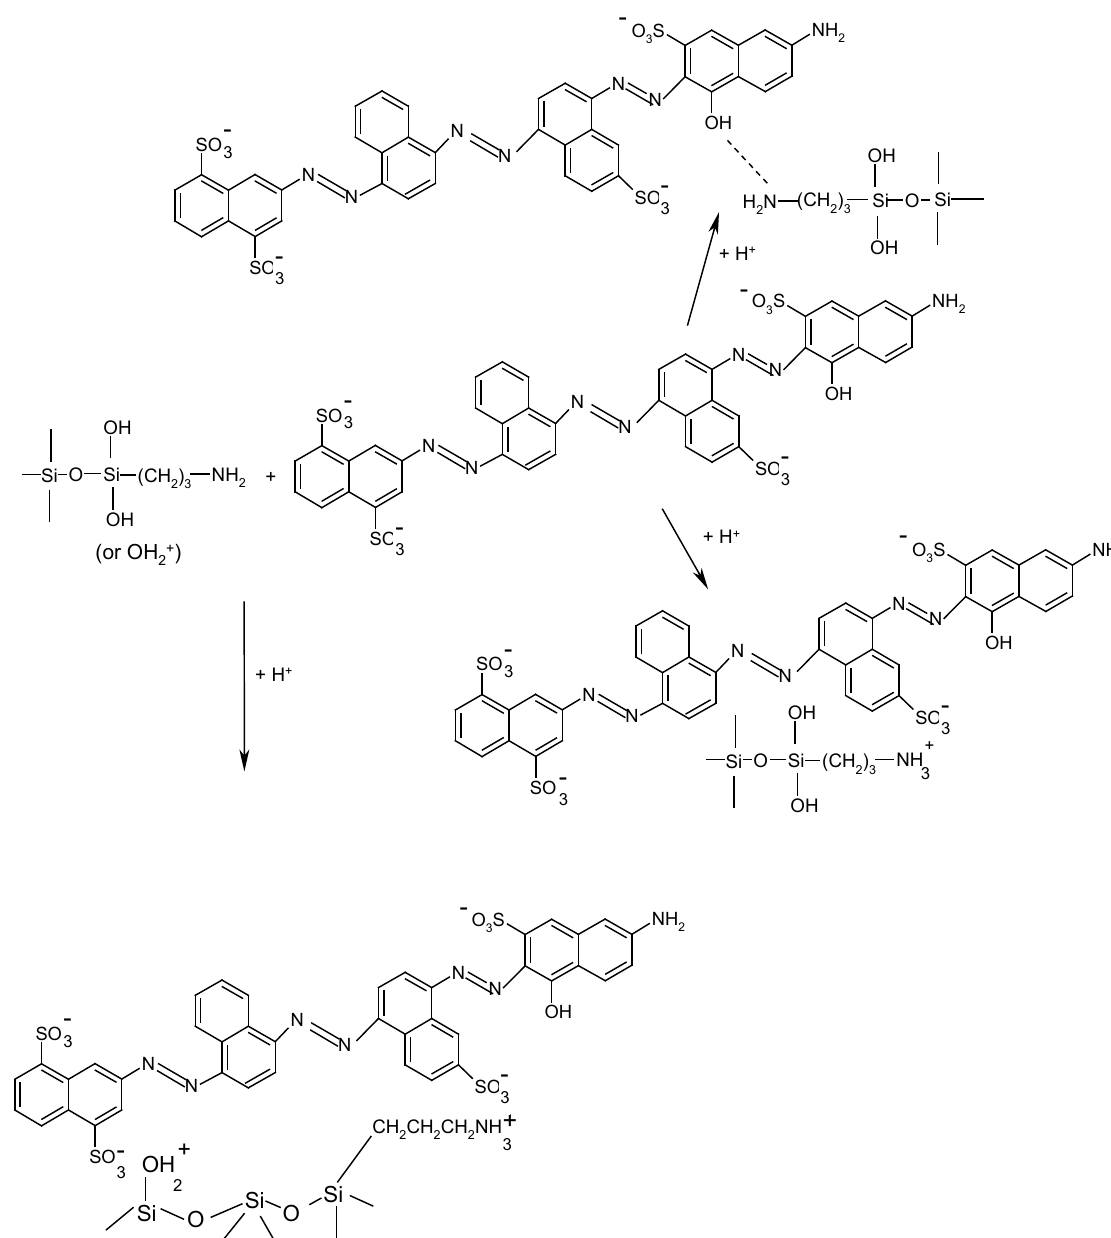
Figure 5: Interactions of C.I. Direct Blue 71 with the surface of the aminosilane modified silica in acidic